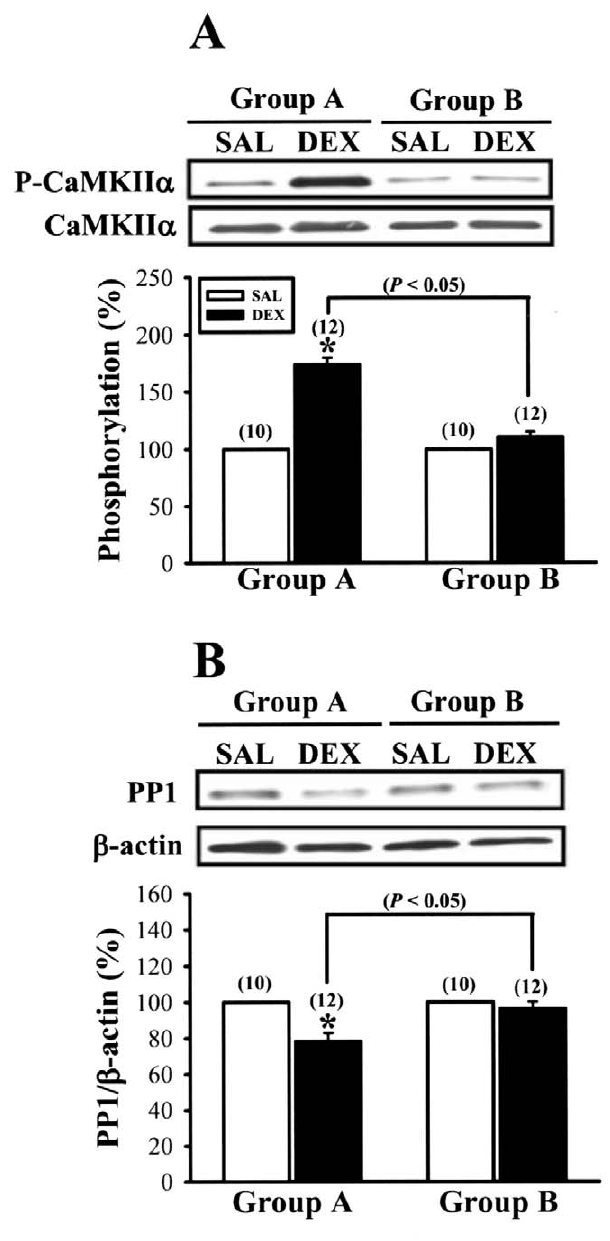
Figure 6. Culling reduces the effects of neonatal DEX treatment on CaMKII a phosphorylation at threonine-286 and PP1 ex- pression in hippocampal CA1 region. (A) Representative Western blot and summary bar graph depicting levels of CaMKII a phosphory- lation at threonine-286 in hippocampal CA1 PSD purified from 5-week- old rats neonatally treated with SAL or DEX for Group A and Group B. (B) Representative Western blot and summary bar graph depicting levels of PP1 in hippocampal CA1 homogenates from 5-week-old rats neonatally treated with SAL or DEX for Group A and Group B. The total number of animals examined is indicated by n in parenthesis. Data represent the mean 6 SEM. *p , 0.05 compared with SAL-treated rats. doi:10.1371/journal.pone.0012806.g006 No significant differences in stimulus-response relationships were found between SAL- and DEX-treated rats of both Group A and Group B (Figure S4A and S4B). We also examined the effect of neonatal DEX treatment on miniature IPSC (mIPSC) properties in hippocampal CA1 neurons. Neonatal DEX treatment did not